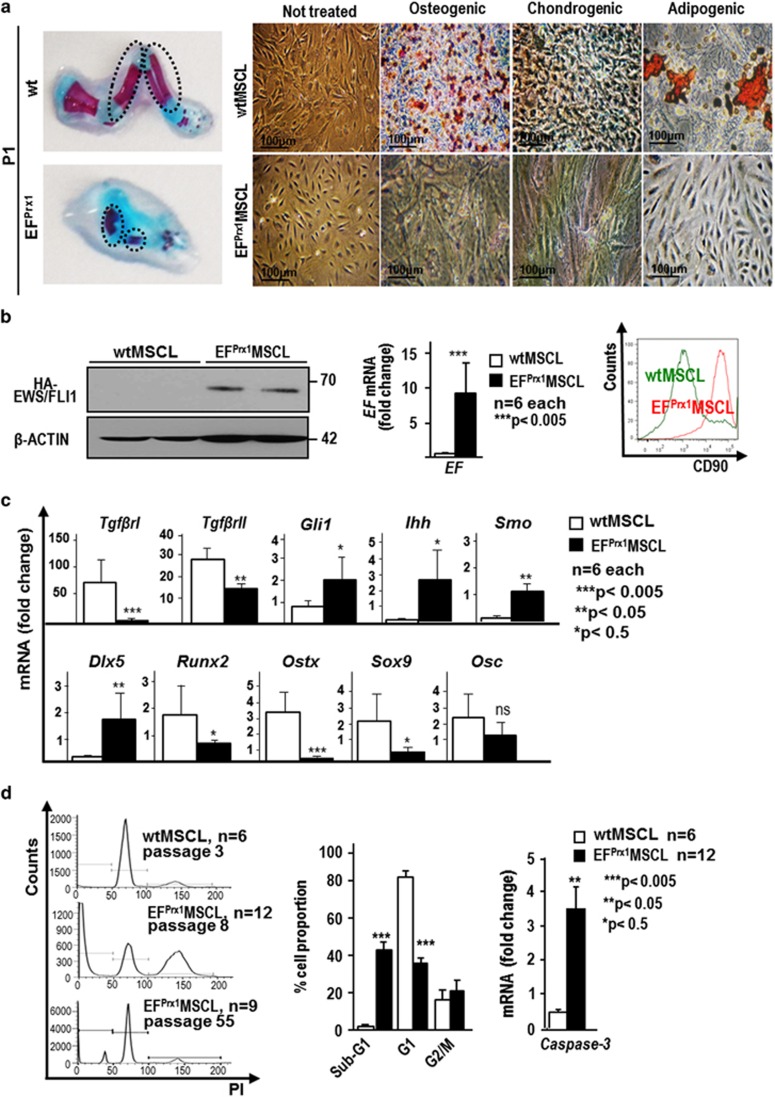
EFPrx1 mesenchymal stem cells like cells (EFPrx1MSCL) are immortal, but display high apoptosis and fail to differentiate. (a) MSCL were isolated from P1 mouse long bone cartilaginous elements of wt or EFPrx1 newborns (left). A representative primary cell line from low passage 3–4 in case of wtMSCL or passage 8–10 in case of EFPrx1MSCL line is shown. WtMSCL were able to differentiate along mesenchymal lineages, whereas EFPrx1MSCL failed to differentiate. Differentiation was induced as detailed in Materials and Methods to obtain osteocytes (stained with Alizarin red), chondrocytes (Van Kossa staining) and adipocytes (Oil red O staining). An example from three independent differentiation experiments is shown (right). (b) Western blot analysis (n=2, each) of HA-tag and qRT-PCR (n=6, each) proved significant EF transgene expression. The EFPrx1MSCL displayed high surface expression of CD90 (Thy-1.1; n=3, each), a MSC marker, compared with wtMSCL. (c) EFPrx1MSCL has blunted TGF-β signaling as measured by reduced expression levels of TgfbrI, TgfbrII and Dlx5. Similarly, osteogenic markers like Osx, Sox9 and Osc were expressed to lower levels, but enhanced hedgehog signaling was found as evident by higher Ihh, Smo and Gli1 expression using qRT-PCR. Error bars represent S.E.M. of six individual measurements. All qRT-PCR results were normalized to Gapdh. For wt or mutant embryos at least three different independent experiments were carried out. (d) Representative cell cycle analysis of six wtMSCL (passage 3) or 12 EFPrx1MSCL at early (passage 8) or late (passage 55) culture time as measured by propidium iodide (PI) staining. Caspase-3 expression was induced in EFPrx1MSCL as measured by qRT-PCR compared with wtMSCL levels causing high apoptosis. *P<0.5, **P<0.05 and ***P<0.005